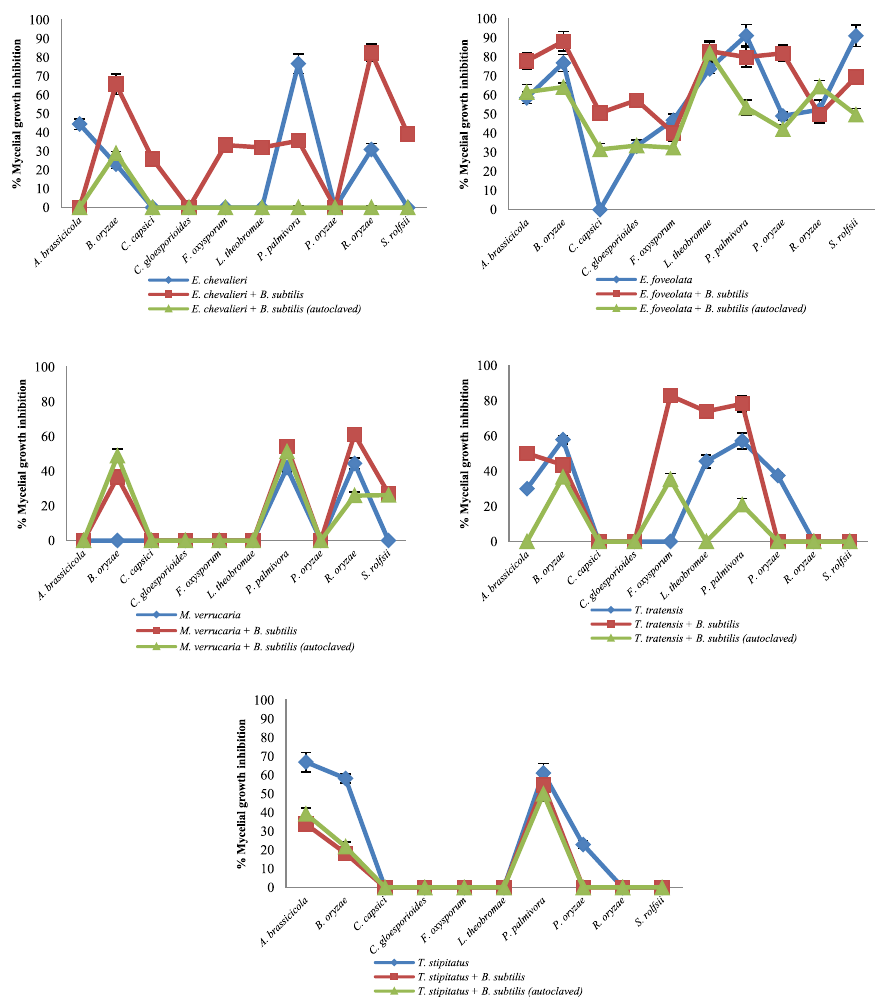
Fig. 2 Inhibitory effect of crude extracts obtained from marine-derived fungi and co-culturing with B. subtilis against plant pathogenic fungi at 1 g L -1